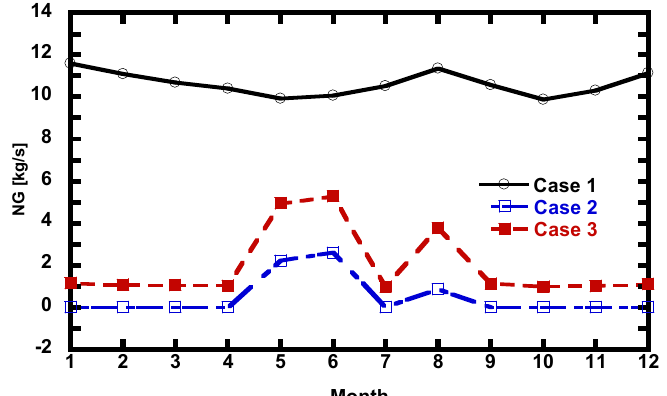
Figure 11. Annual NG consumption.